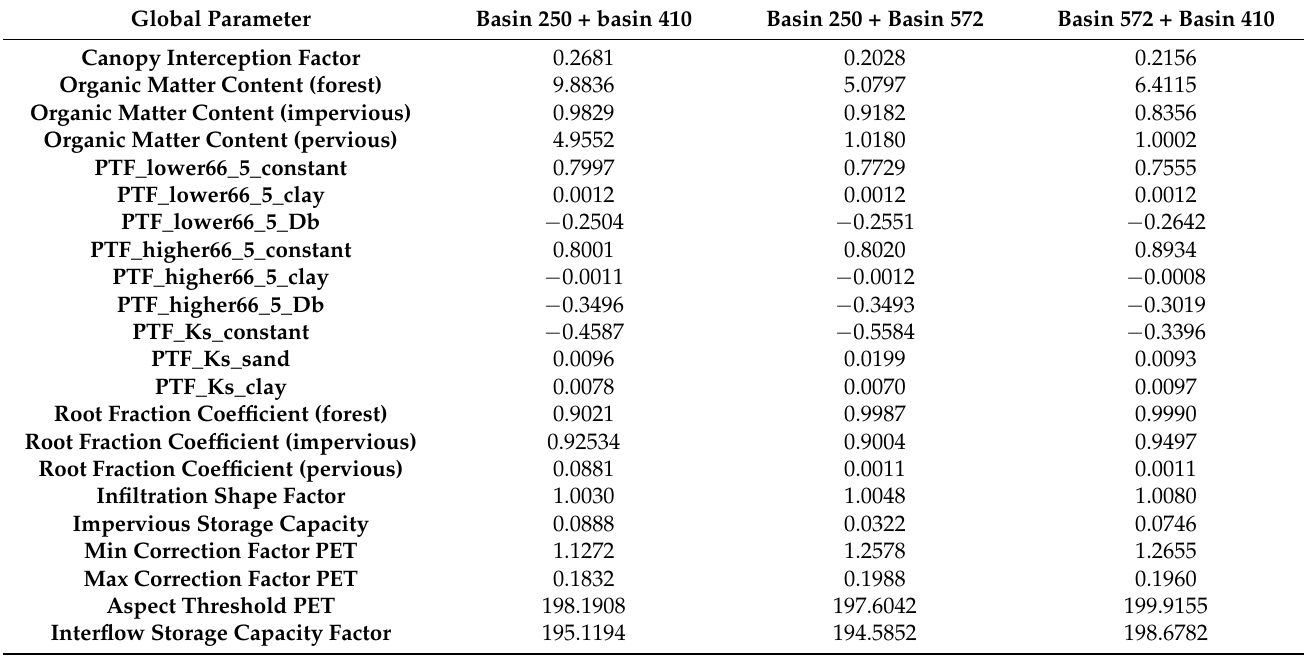
Table A2. Values of optimized global parameters for different multi-basin mHM